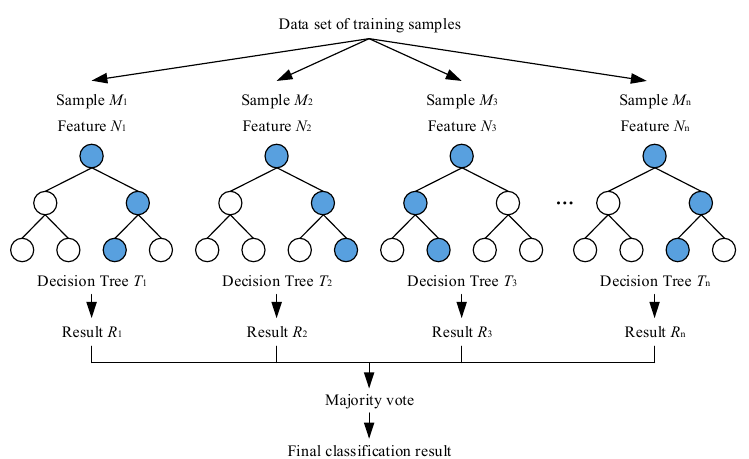
Figure 1. The principle of